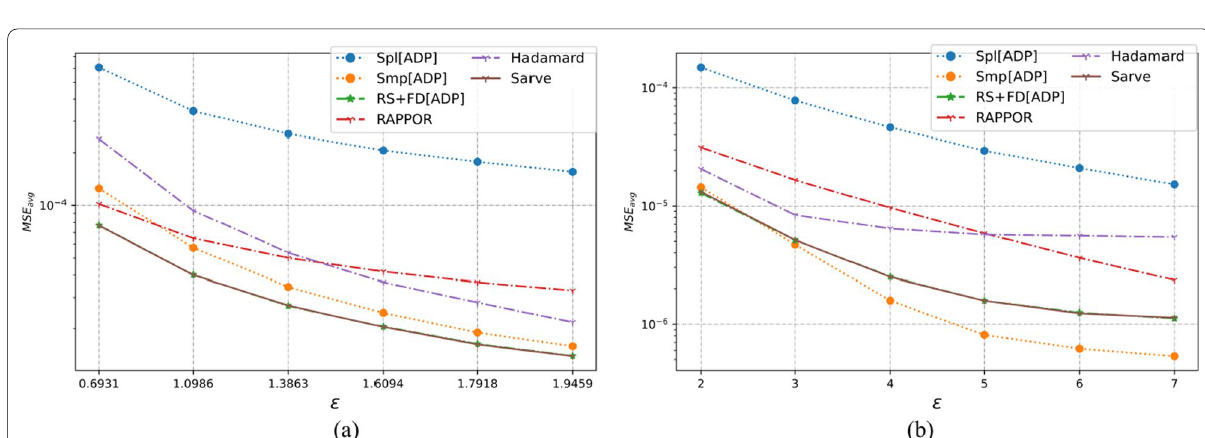
Fig. 12 The MSE averaged over 100 runs for synthetic non-uniform data with N techniques and fake data under a high privacy regime, experimental setup labeled ES_Syn_5 in Table 2; b general privacy regime, experimental setup labeled ES_Syn_11 in Table